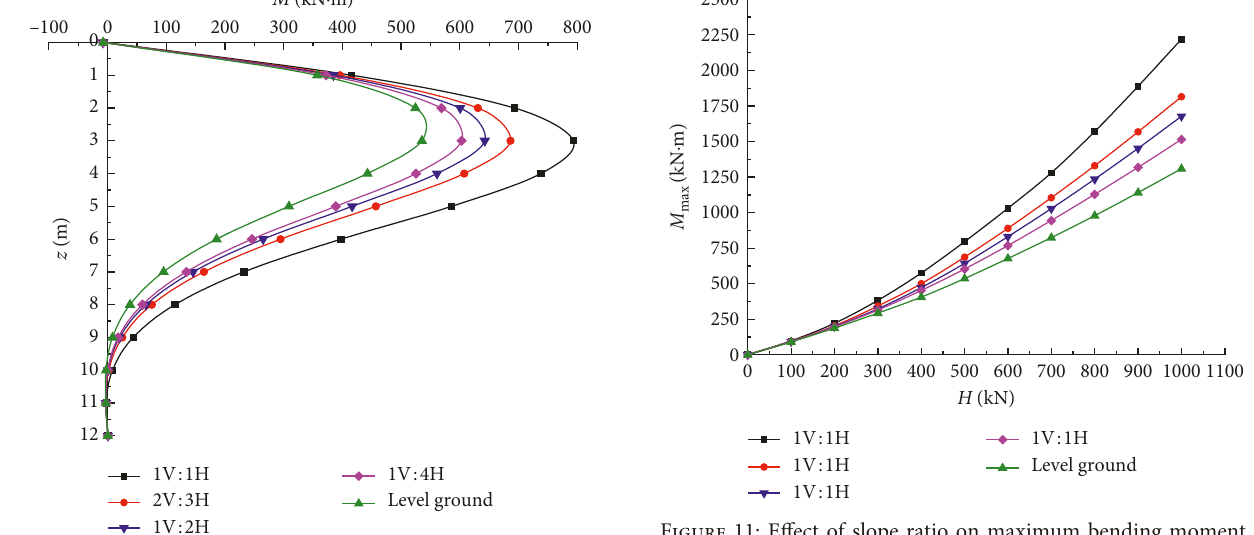
Figure 9: Bending moment of the pile versus depth relationships of 500kN. different slope ratios for H 0 (cid:31)